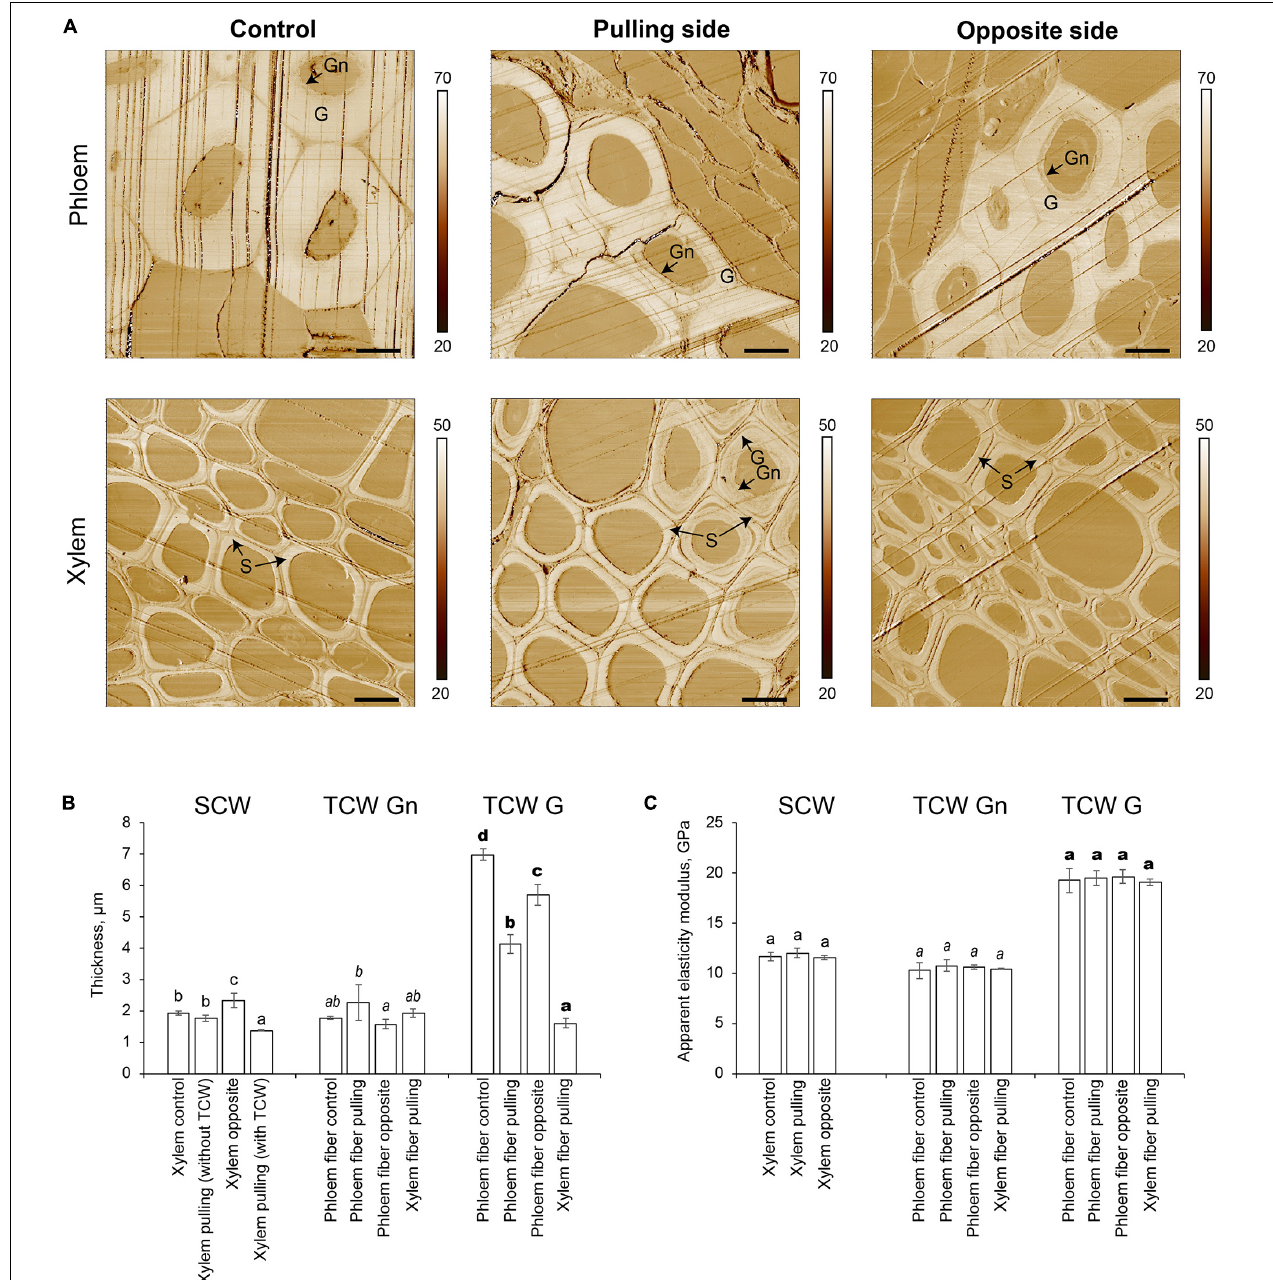
FIGURE 3 | Atomic force microscopy of fiber cell walls in control and gravistimulated flax plants 96 h after stem inclination. (A) Stiffness (N/m) maps of phloem (top) and xylem (bottom) fibers in control and gravistimulated flax plants. One representative image for each variant is shown. Stiffness scales are on the right side of each map. Bars are 10 µ m. G- and Gn-layers of tertiary cell walls in phloem and similar structures in the cell walls of xylem fibers on the pulling side are indicated. S indicates secondary cell walls. Parallel lines on each image are scratches left by the knife. (B) Thickness ( µ m) and (C) Apparent elasticity modulus (GPa) of different cell wall layers. SCW, secondary cell walls; TCW, tertiary cell walls. Values are the mean ± SD. Different letters above the bars indicate a significant difference according to one-way ANOVA followed by Tukey’s test at α = 0.01 (individual comparisons are shown by regular, italic, and bold-type fonts of these letters).